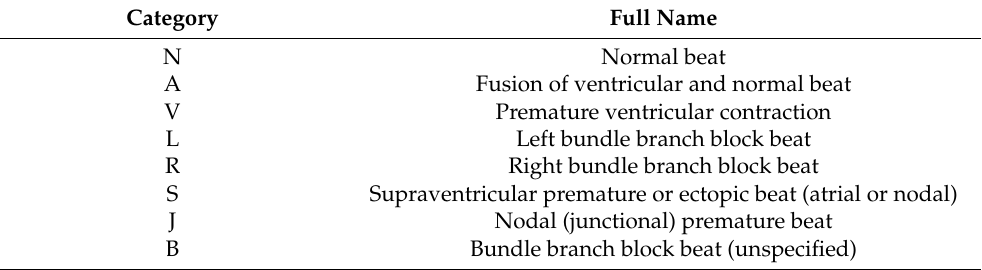
Table 2. Complete category